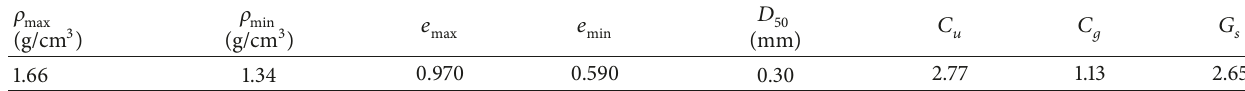
Table 2: Property parameters of sand.